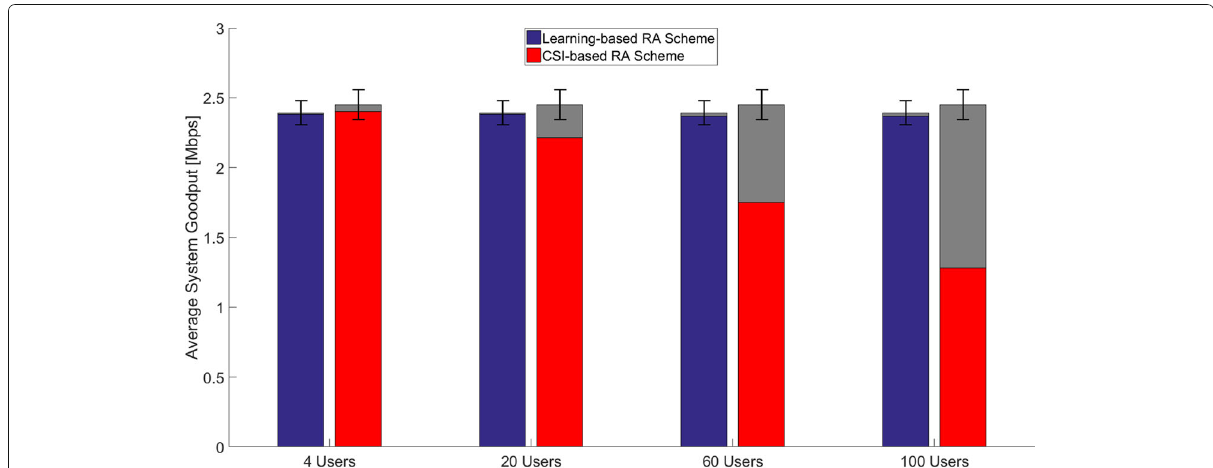
Fig. 5 Effect of overhead on average system goodput for different RA schemes and user terminal density, for perfect position and CSI estimates of all terminals